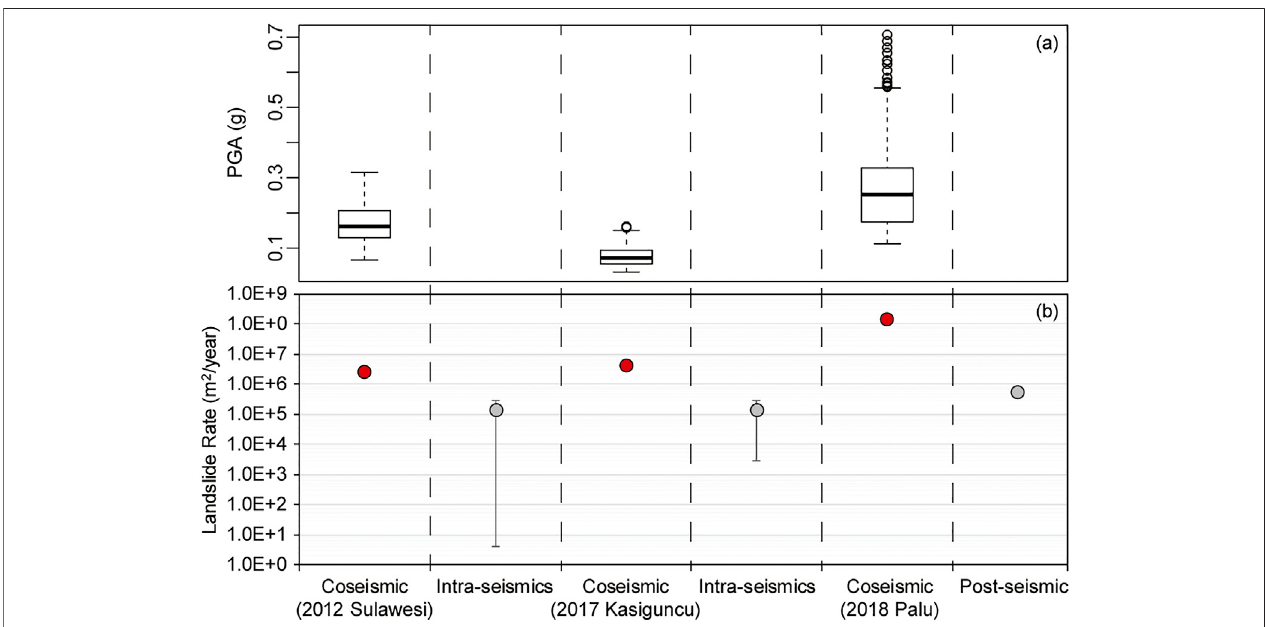
FIGURE 8 | Plot showing (A) central tendencies and ranges of PGA for Sulawesi, Kasiguncu and Palu earthquakes and (B) the evolution of landslide rates in time for both co-seismic and post-seismic (intra-seismic) landslides. The error bars are given for the fi rst standard deviation of landslide rates for each examined and post- seismic (intra-seismic) set of